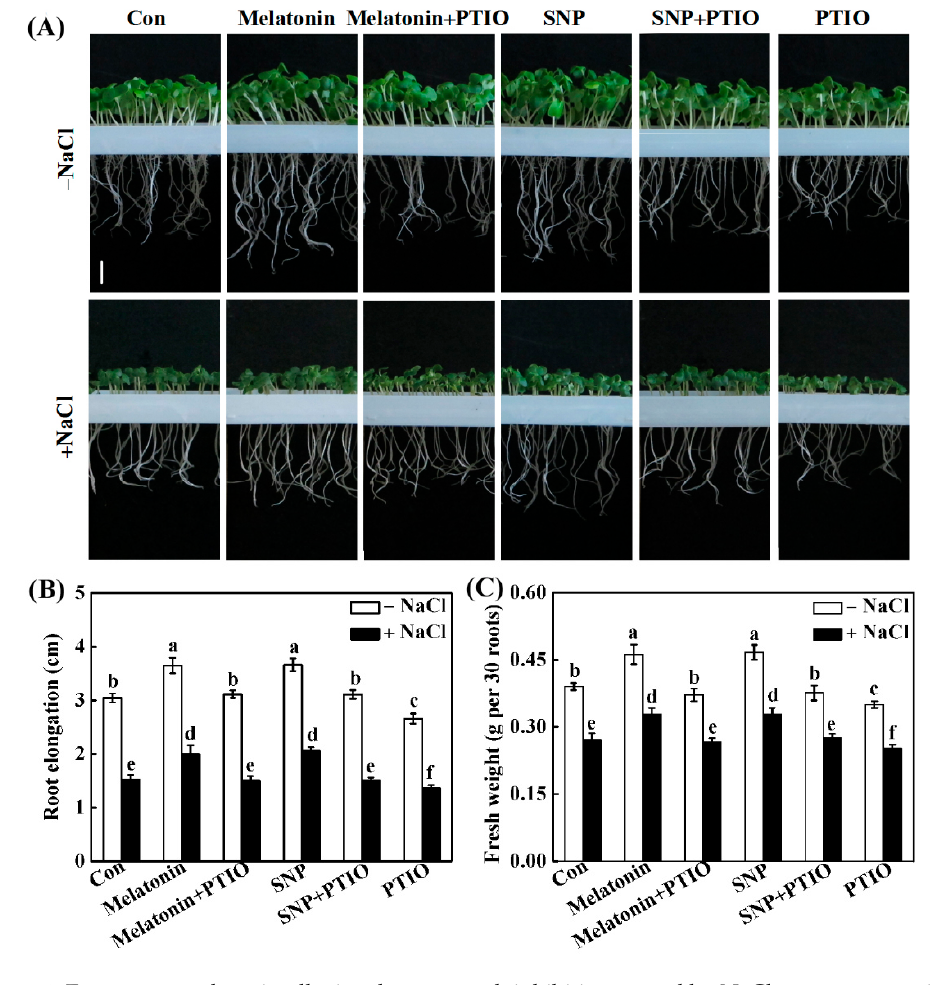
Figure 4. Exogenous melatonin-alleviated root growth inhibition caused by NaCl stress was sensitive to the removal of NO. Three-day-old rapeseed seedlings were pretreated with 1 µ M melatonin, 10 µ M SNP, 200 µ M PTIO, alone or their combinations for 12 h, and then transferred to 200 mM NaCl for 2 days. Afterwards, corresponding photographs were taken (( A ); bar: 1 cm). The root elongation ( B ) and root fresh weight ( C ) were measured. The sample without chemicals was the control (Con). Values are means ± SE of three independent experiments with at least three replicates for each. Bars with different letters are significant different at p < 0.05 according to Duncan’s multiple range